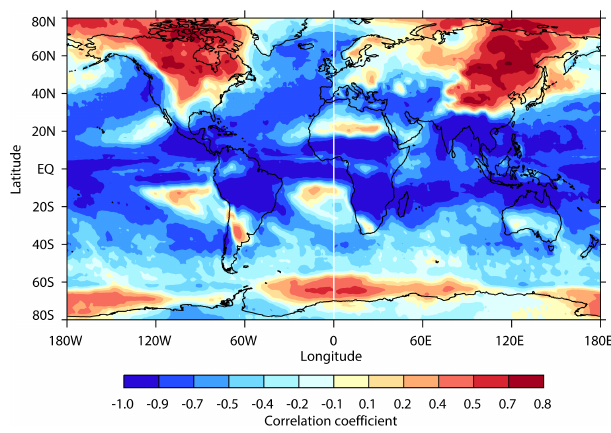
Figure A1. Global map of the temporal correlation between OLR and precipitation. In regions where OLR is a good proxy for con- vection, a strong negative correlation is